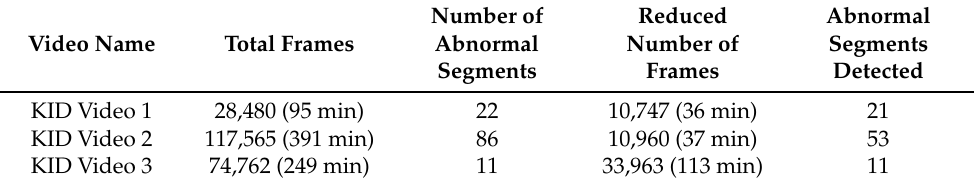
Table 3. Ensemble of Networks Trained on Non-Augmented